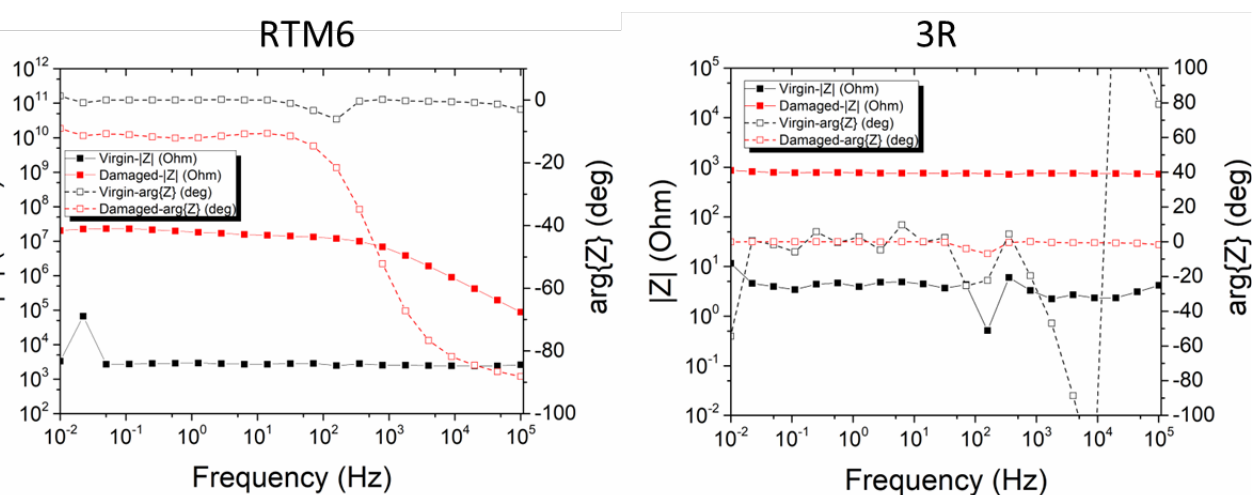
Figure 5. IS scans of ( left ) a representative RTM6 ILSS specimen before (black) and after damage (red), and ( right ) a 3R specimen before (black) and after damage (red).